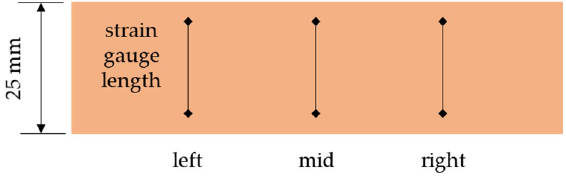
Figure 11. Location of the virtual strain gauges.